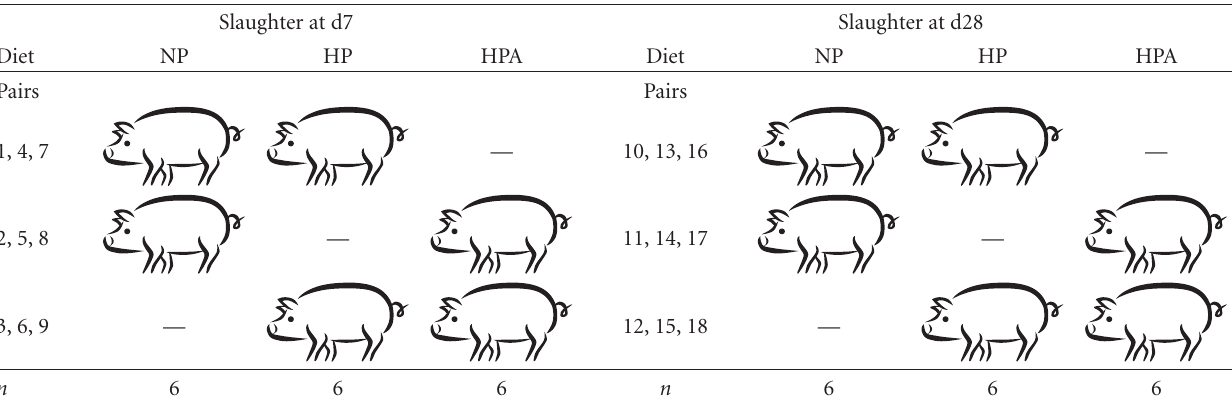
Table 1: Experimental incomplete block